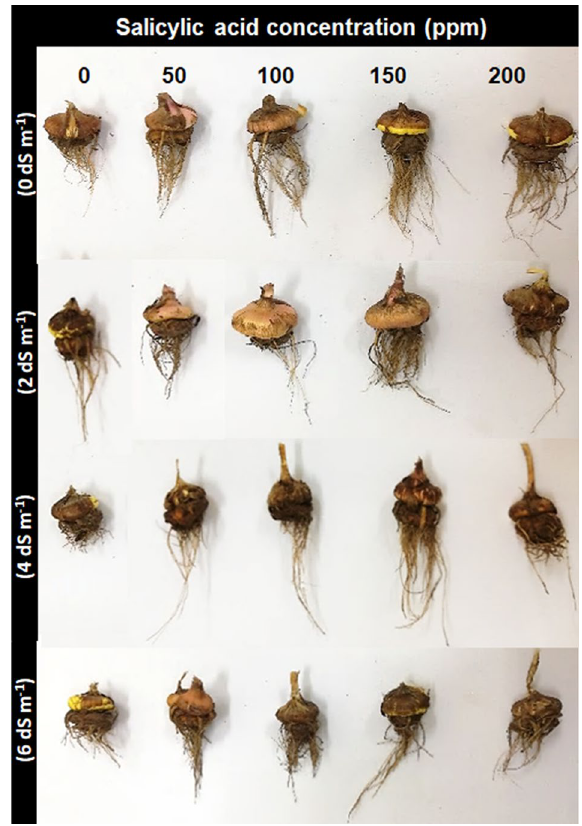
Figure 2. Effect of salicylic acid on corm of Gladiolus grandiflorus under salinity stress 90 days after sowing.